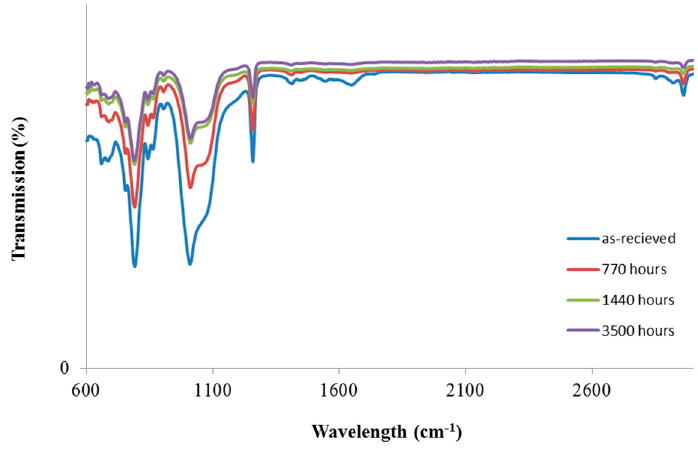
Figure 4. FTIR-ATR spectra of aged Si in a salt batch at 100 °C.